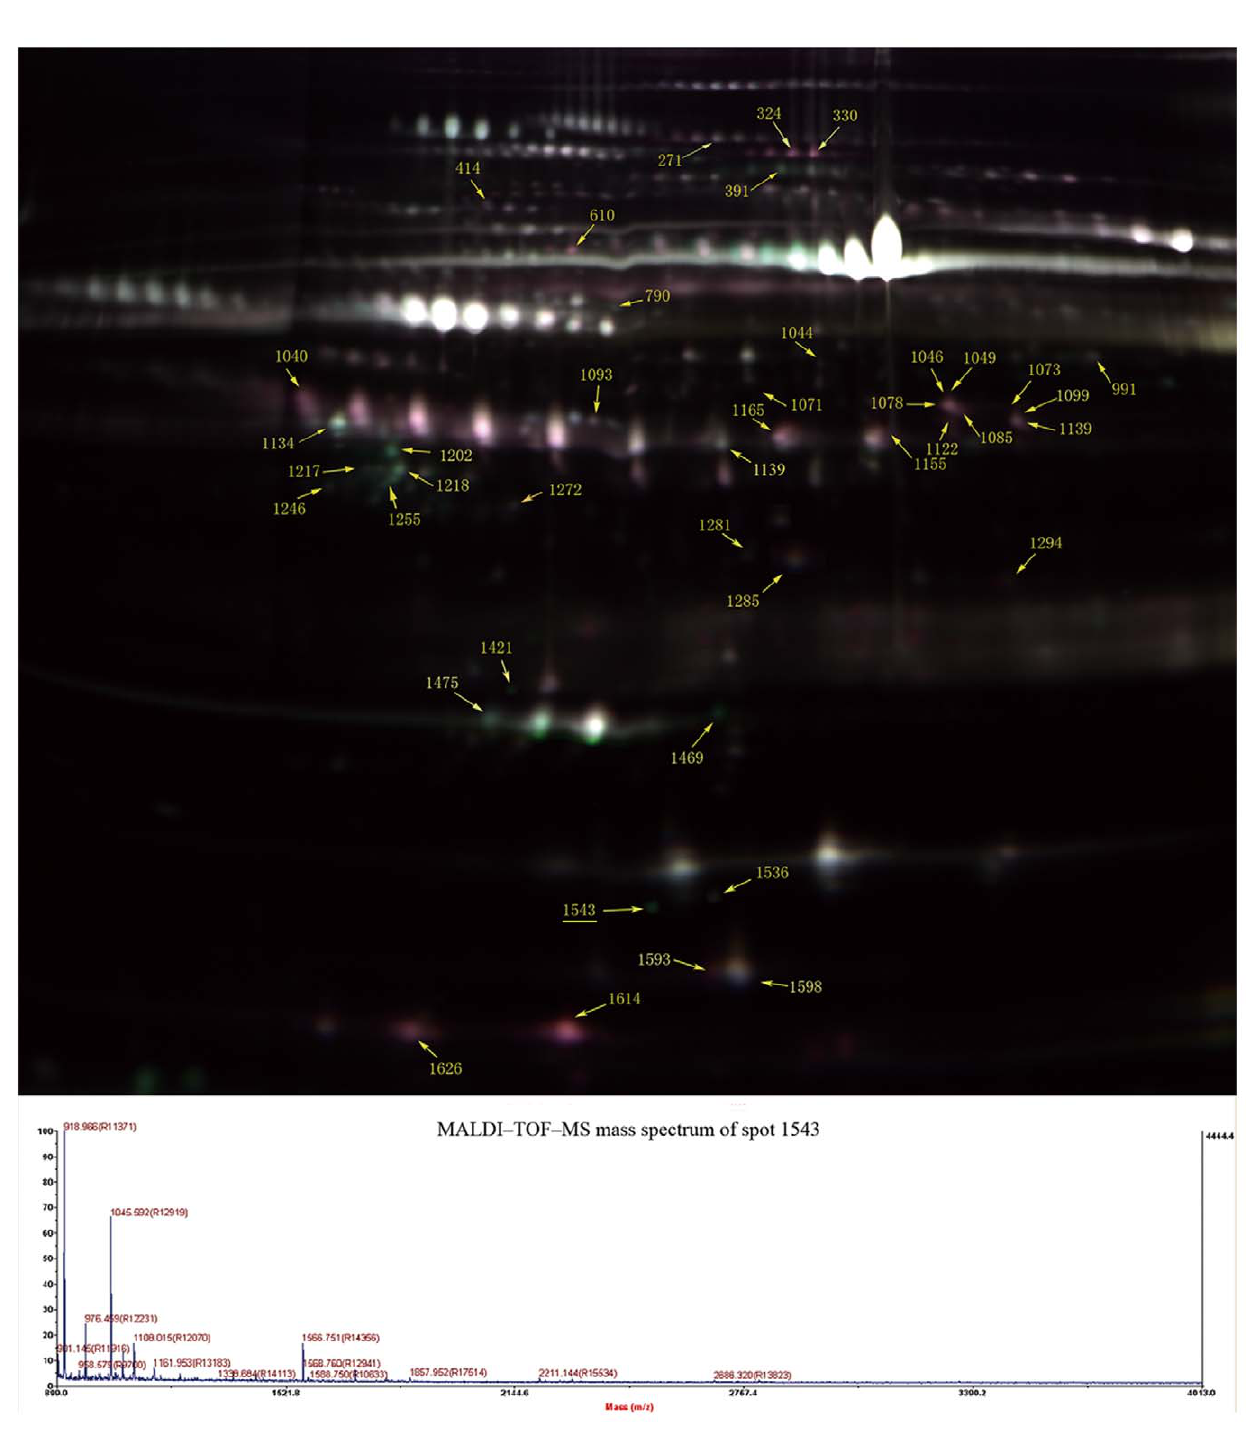
Figure 2. (top) Proteomic analysis of ascites by 2D-DIGE. A representative 2D-DIGE image (merged image) showing the protein profile of ascites of chemosensitive and chemoresistant ovarian cancer patients labeled with Cy5 (red spots) and Cy3 (green spots), respectively, with an internal standard labeled with Cy2. IPG strips (24 cm, pH 4-7) were used for IEF prior to standard SDS-PAGE (12.5% polyacrylamide) for the second dimension. The molecular weight range in the vertical dimension is approx from 150 to 10 kD. Proteins identified as differentially expressed are indicated with yellow arrows with assigned numbers from the DeCyder analysis. The numbers in the figure correspond to those presented in Table 2; (bottom) MALDI–TOF–MS mass spectrum of spot 1543 identified as ceruloplasmin according to the matched peaks. doi:10.1371/journal.pone.0051256.g002 as isoforms. For example, haptoglobin and transthyretin were the same protein being present in several different spots could have represented by two and three spots, respectively, and in both cases, represented biologically relevant modifications or proteolytic the individual spots were similarly down-regulated. Additionally, fragments (e.g., ceruloplasmin).